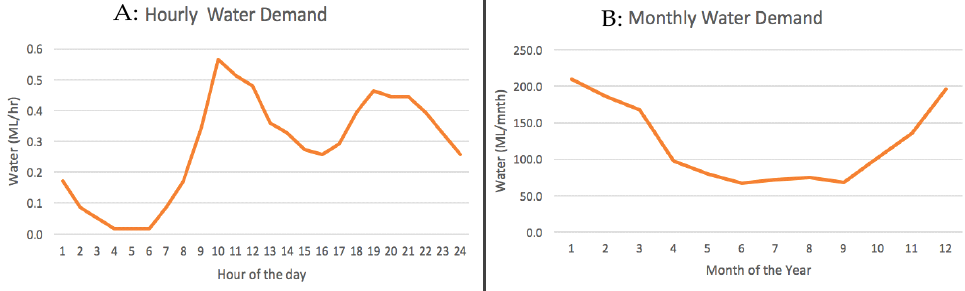
Figure 5. Freshwater consumption profile on ( A ) hourly (the data is plotted for 1 January); and ( B ) monthly basis.